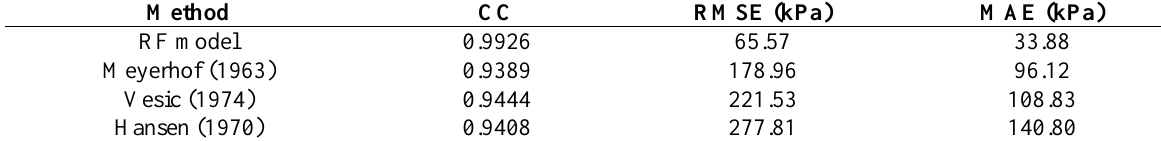
Table 5. Comparison between RF model with theoretical methods